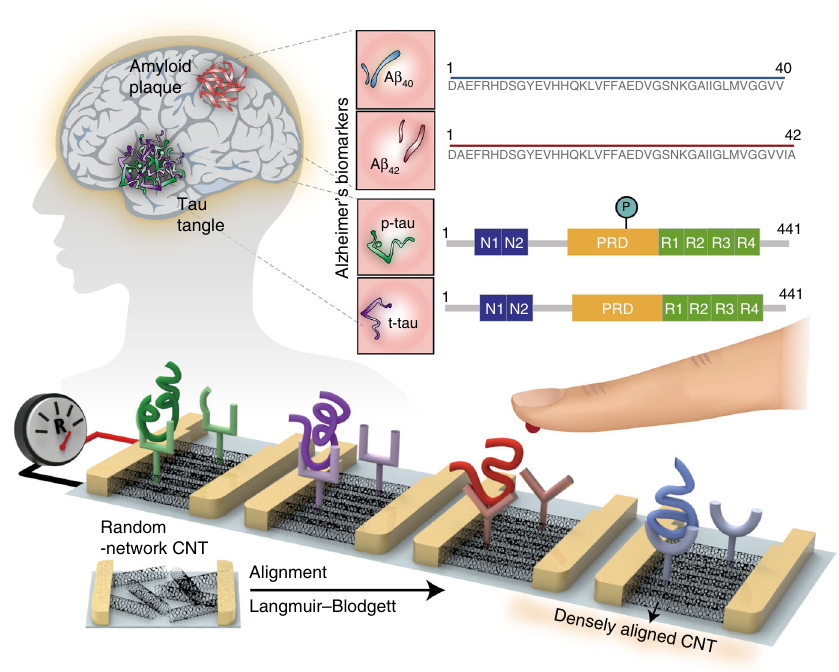
Fig. 1 Schematic illustration of a densely aligned CNT sensor array for AD biomarkers. The unidirectional aligned and highly dense CNTs facilitate femtomolar sensitivity and high sensor-to-sensor reliability. The densely aligned CNT sensor array exhibited diagnostic accuracy of ~88.6% in discriminating AD patients from healthy